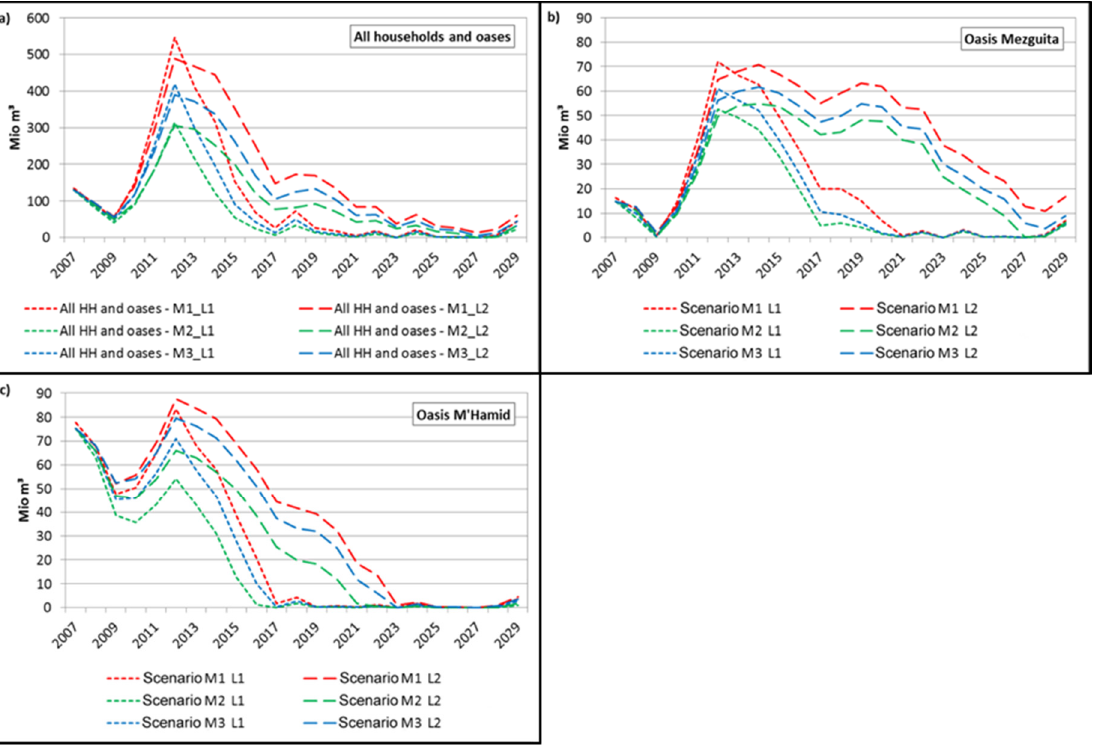
Figure 7. Mean annual groundwater storage in million m 3 of the sub-scenarios L1 (small dashed line) and L2 (long dashed line) within the three IMPETUS scenarios M1 (red), M2 (green), and M3 (blue) (2007–2029) for ( a ) all demand sites; ( b ) the oasis Mezguita; ans ( c ) the oasis M’Hamid. The groundwater bodies of L2 are emptied slower than those of L1. The oasis Mezguita shows a strong stability in groundwater table, particularly in scenario L2. After strong recharging events in 2010 and 2011 all aquifers are running empty with time.